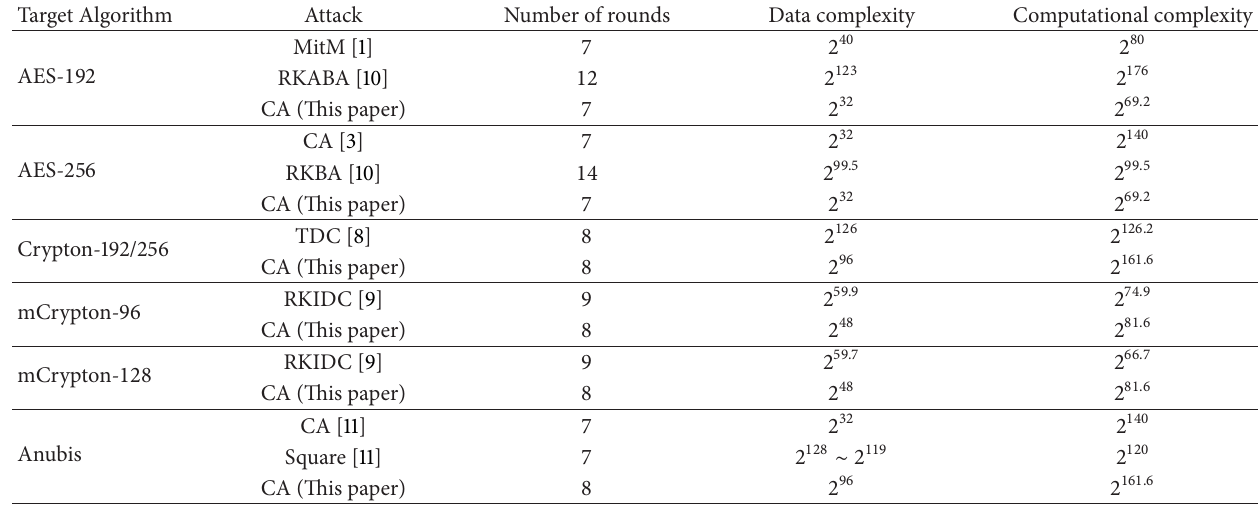
Table 1: Our attack results on AES-192/256, Crypton-192/256, mCrypton-96/128, and Anubis. Target